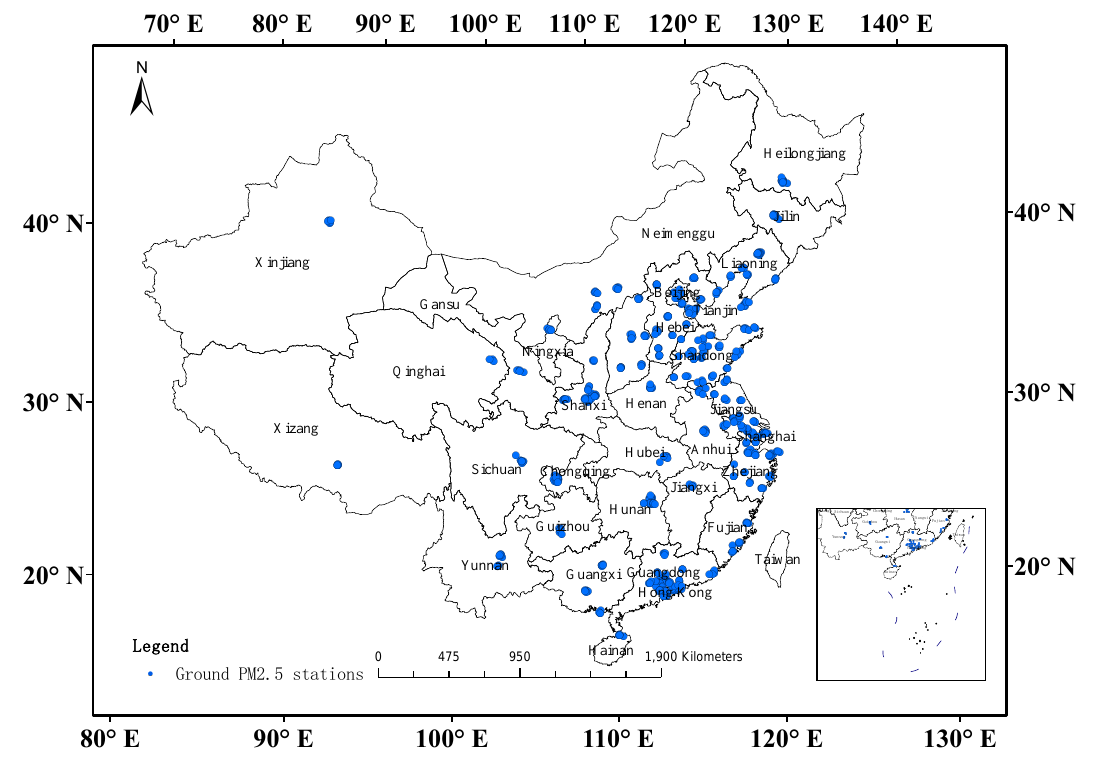
Figure 1. PM 2.5 monitoring sites over mainland China.